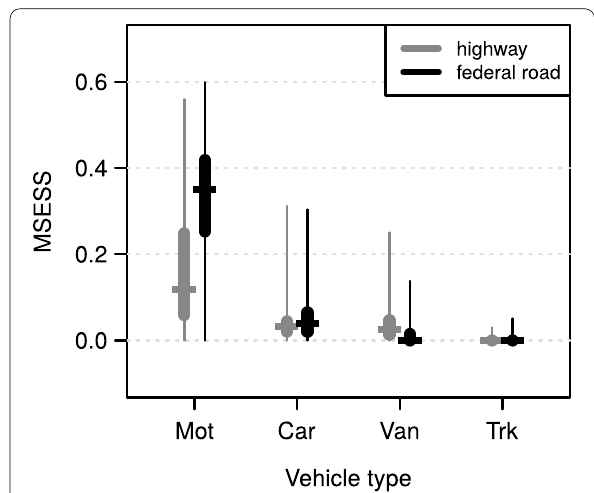
Fig. 2 Distributions of mean squared error skill scores (MSESS). The MSESS compares models with (MET) to models without (NO_MET) meteorological predictor variables, separated by vehicle and road type. Box and whisker plots indicate the variability of the MSESS between different traffic stations with the median (horizontal lines), interquartile range (thick vertical lines) and minimum and maximum values (thin vertical lines) of the